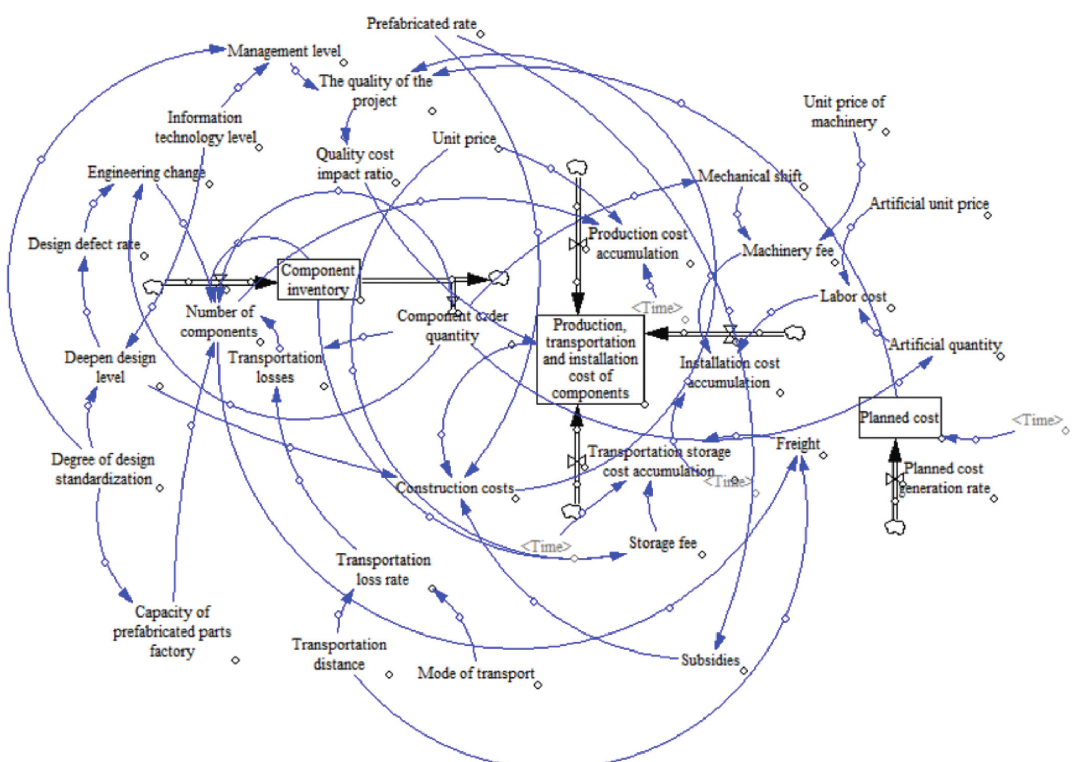
Figure 3: Flowchart of cost control stock of prefabricated building construction.